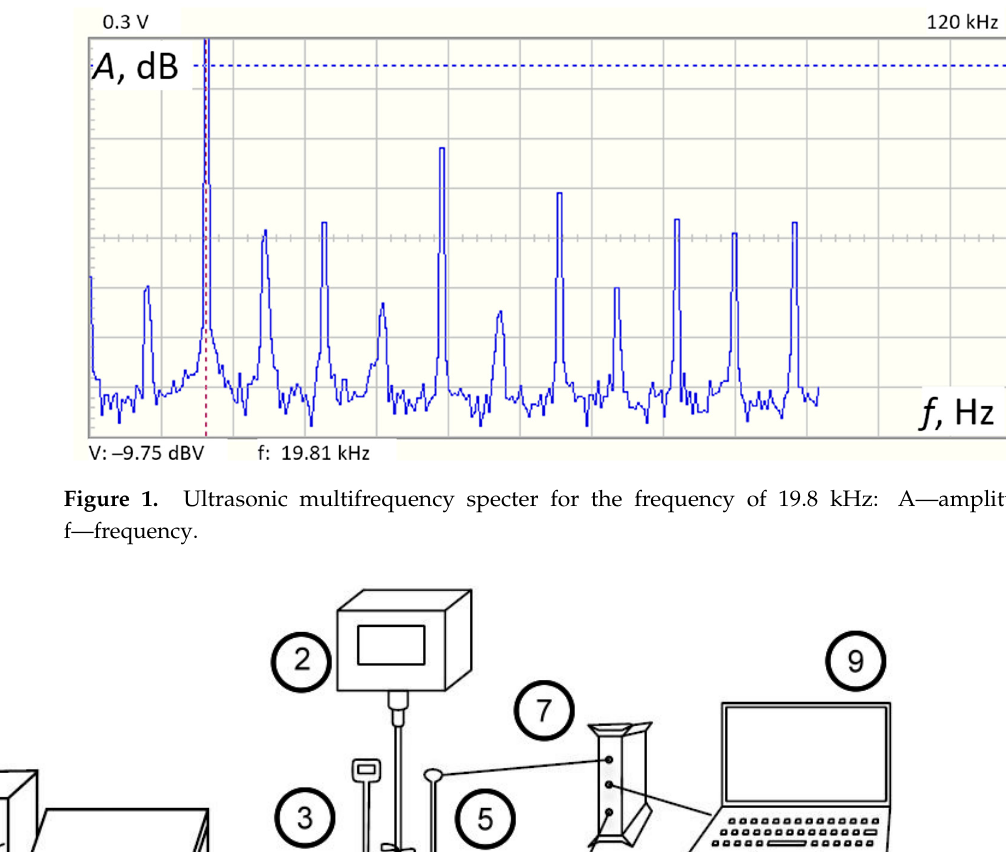
Figure 1. Ultrasonic multifrequency specter for the frequency of 19.8 kHz: A—amplitude; f—fre- quency.